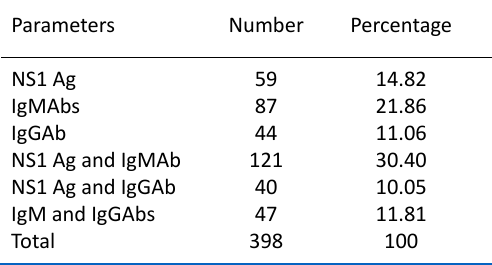
Table 2. Seropositivity Pattern in dengue